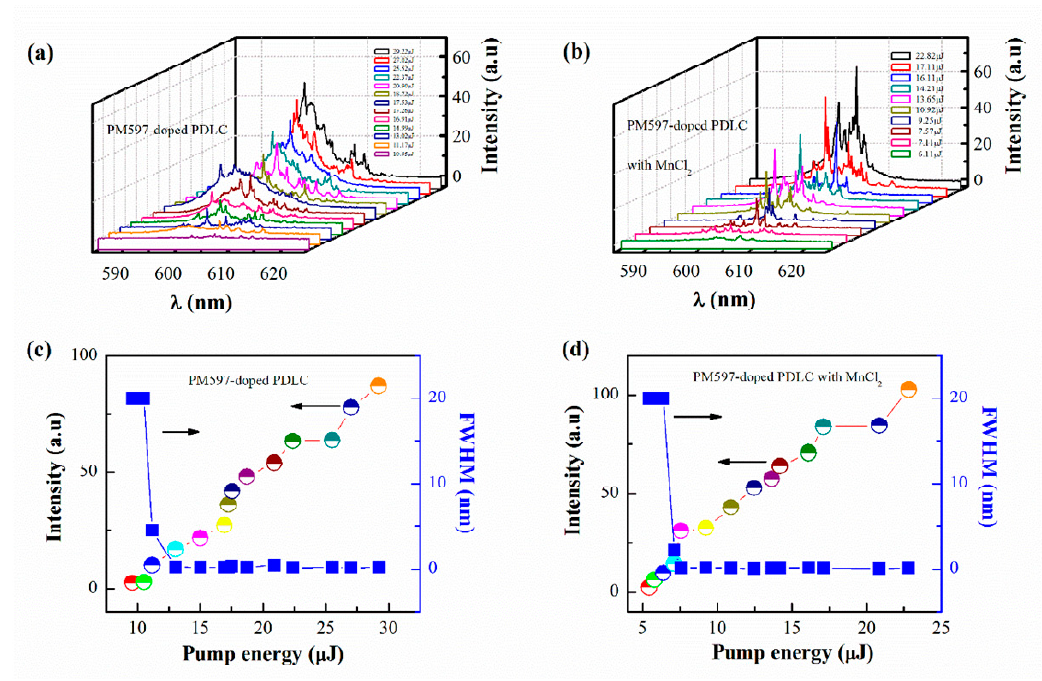
Figure 3. Emission spectra as a function of pump energies for ( a ) PM597-doped PDLC and ( b ) PM597-doped PDLC and MnCl 2 (0.1 mL) systems, respectively. Main-peak intensities and FWHM of emission spectra versus pump energies for ( c ) PM597-PDLC and ( d ) PM597-doped PDLC and MnCl 2 (0.1 mL) systems, respectively.